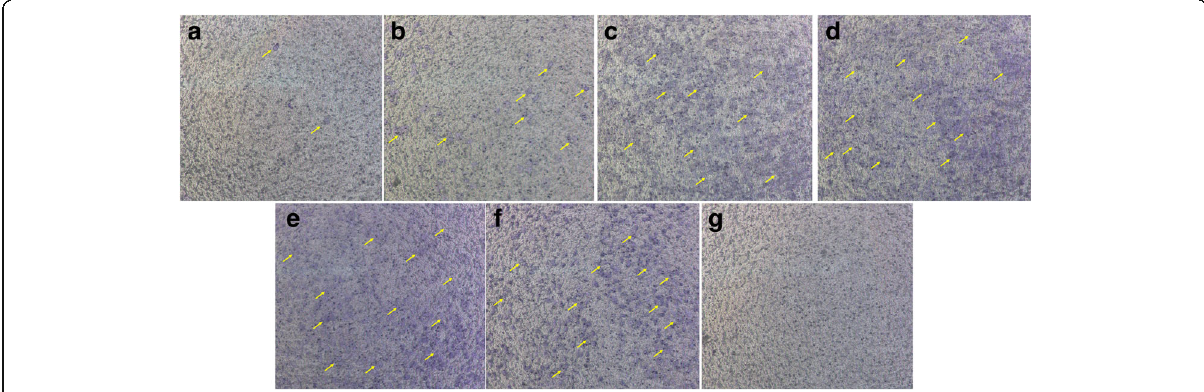
Fig. 5 KFX and PC substance promote HUVECs migration. The migration properties of HUVECs are measured using a transwell migration assay. a Blank control (untreated), b KFX (0.1 mg/mL), c KFX (1 mg/mL), d KFX (5 mg/mL), e PC substance (0.1 mg/mL), f PC substance (1 mg/mL), g PC substance (5 mg/mL). Migrating endothelial cells are indicated by yellow